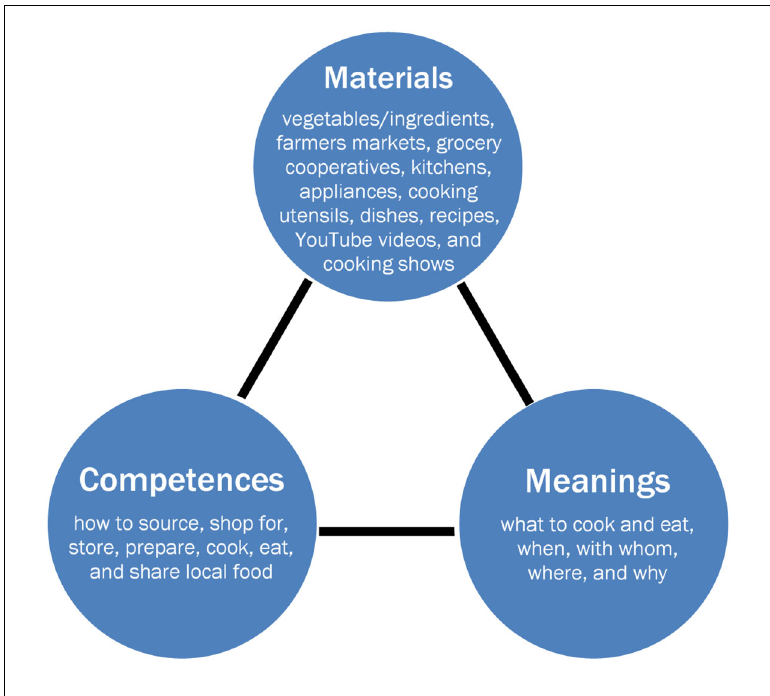
Figure 1. The Practice of Eating Local Vegetables